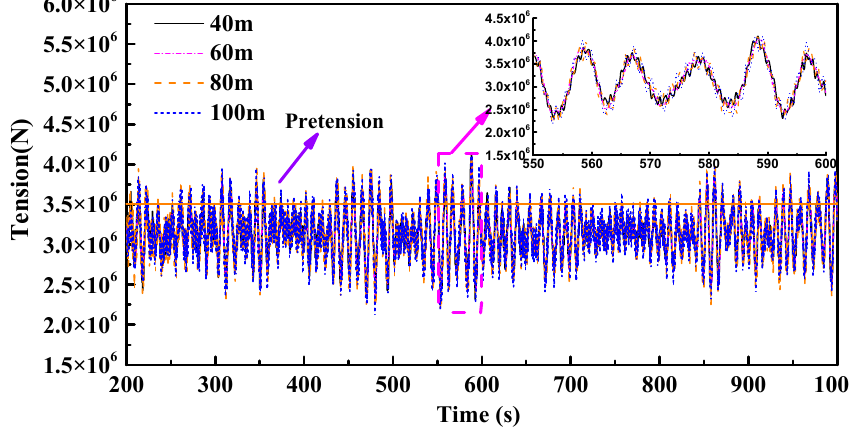
Figure 8. Time series of tether 1# tension for different tether lengths.